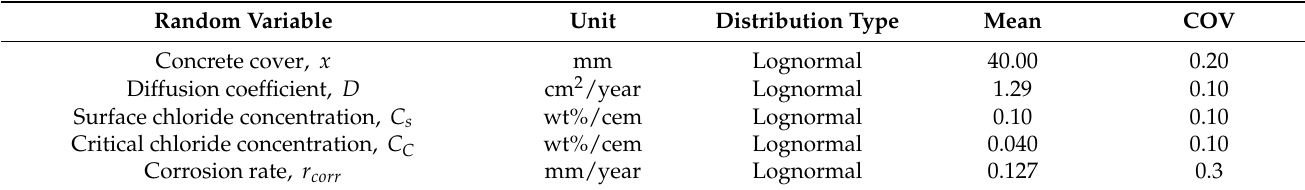
Table 2. Probability distribution and the random parameters involved in the diffusion